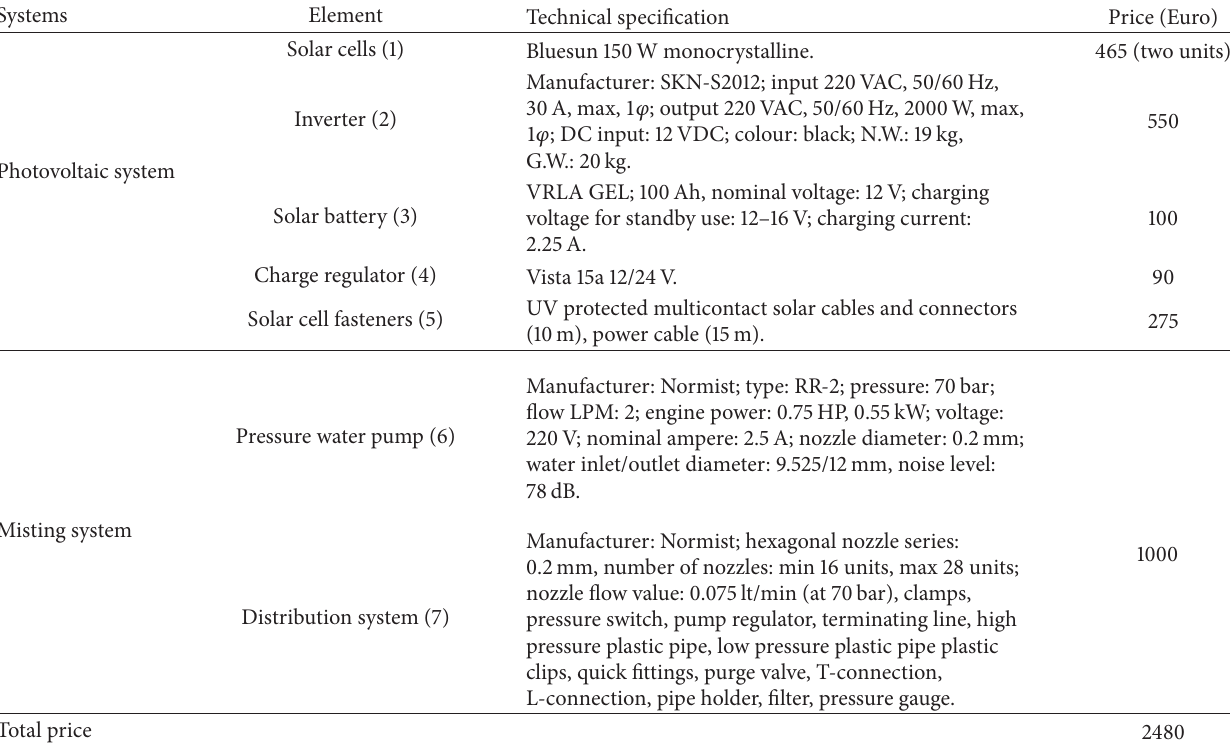
Table 3: The main components specification and characteristics of the photovoltaic misting system